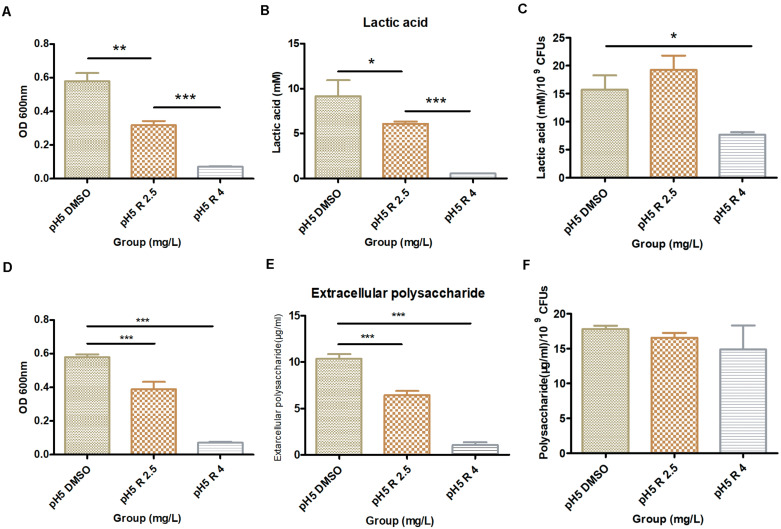
Effect of 2.5 and 4.0 mg/L of bedaquiline and DMSO on lactic acid production and water-insoluble extracellular polysaccharide production within S. mutans biofilm in pH 5 BHI. (A) OD600 nm value of S. mutans biofilm used for lactic acid detection. (B) Lactic acid production detection in different groups. (C) Lactic acid production/109 CFUs of different groups. (D) OD600 nm value of S. mutans biofilm used for water-insoluble extracellular polysaccharide detection. (E) Extracellular polysaccharide detection in different groups. (F) Extracellular polysaccharide production/109 CFUs of different groups. *, **, and *** indicate statistically significant differences at p < 0.05, p < 0.01, and p < 0.001, respectively. Error bars are standard deviations.